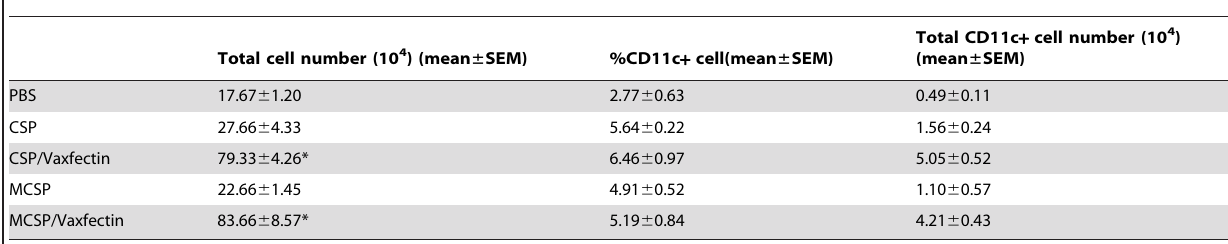
Table 1. Impact of Different Immunization Regimens on Cellular Infiltrate at Site of